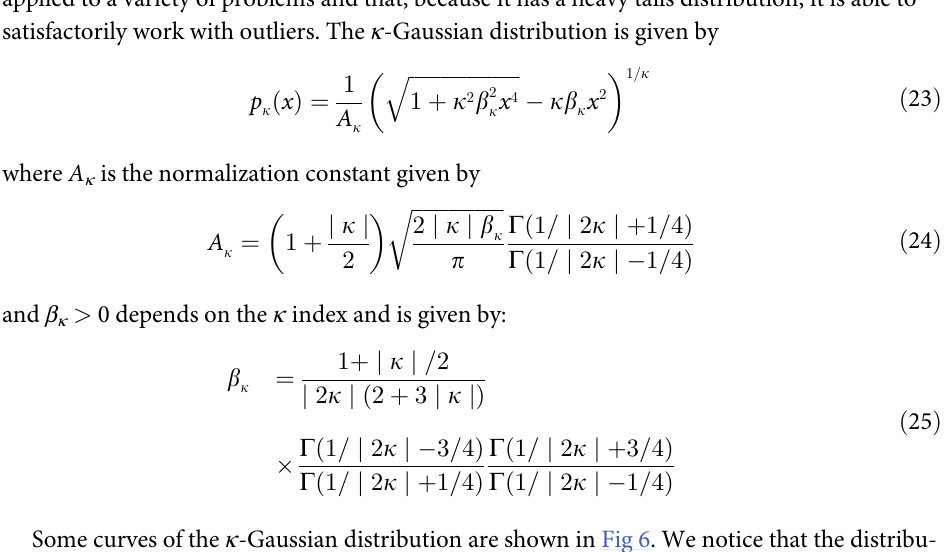
ffiffiffiffiffiffiffiffiffiffiffiffiffiffiffiffiffiffi 2 j k j b